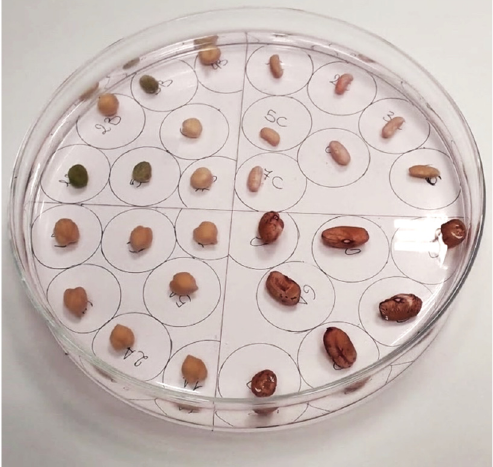
Figure 4. Arrangement of the different varieties of seeds on a gridded plate.